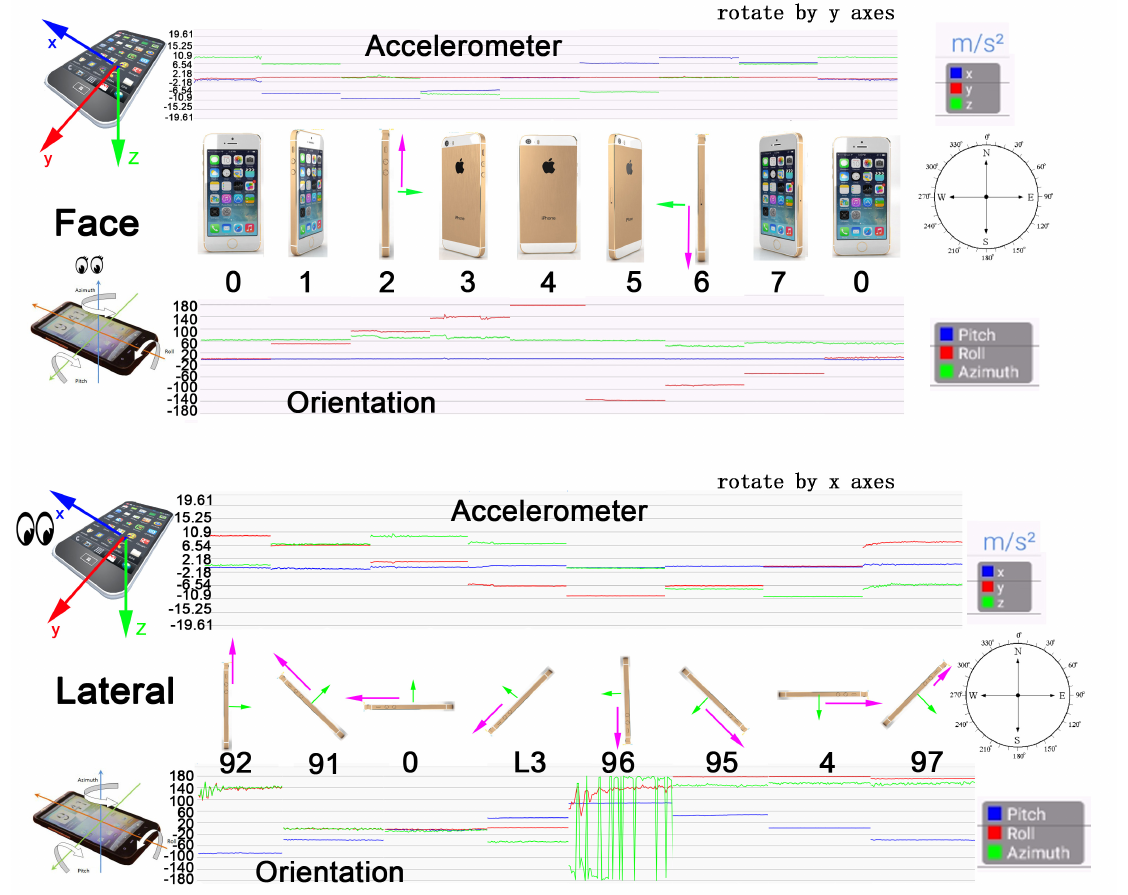
Figure 2. Accelerometer and orientation data (pitch, roll, azimuth) in various